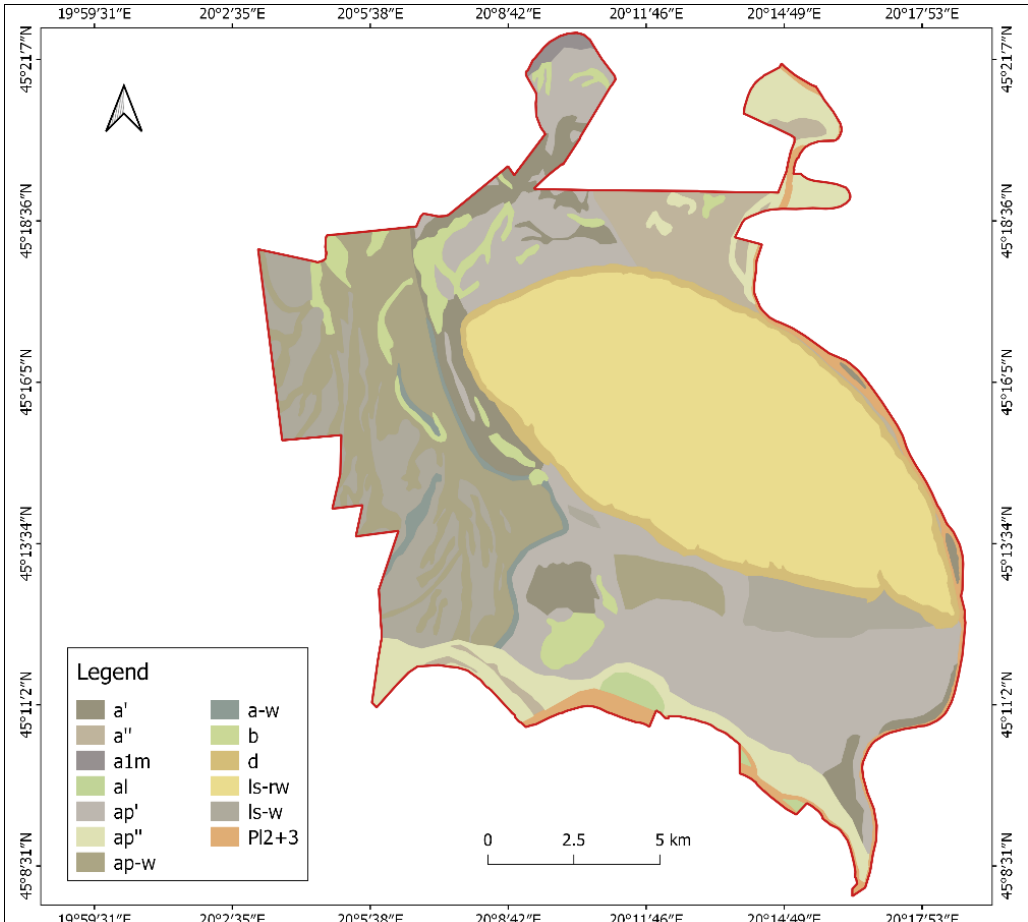
Figure 6. Geology map of the study area (ap—w—flood sediments of the second fluvial terrace; ap’—flood sediments of the first fluvial terrace; ap”—flood sediments; Pl 2+3 —gravel, siltstone sand, sandy—clayey siltstones; b—sediments of swamps; a—w-stream bed sediments of the second fluvial terrace; a’—stream bed sediments of the first fluvial terrace; al—Alluvium; a”—stream bed sediments; a 1 m—clay and siltstone in oxbow lake; ls—w—lesoidal on the surface of the second fluvial terrace; d—deluvium; ls—rw—lesoidal on the loess plateau).